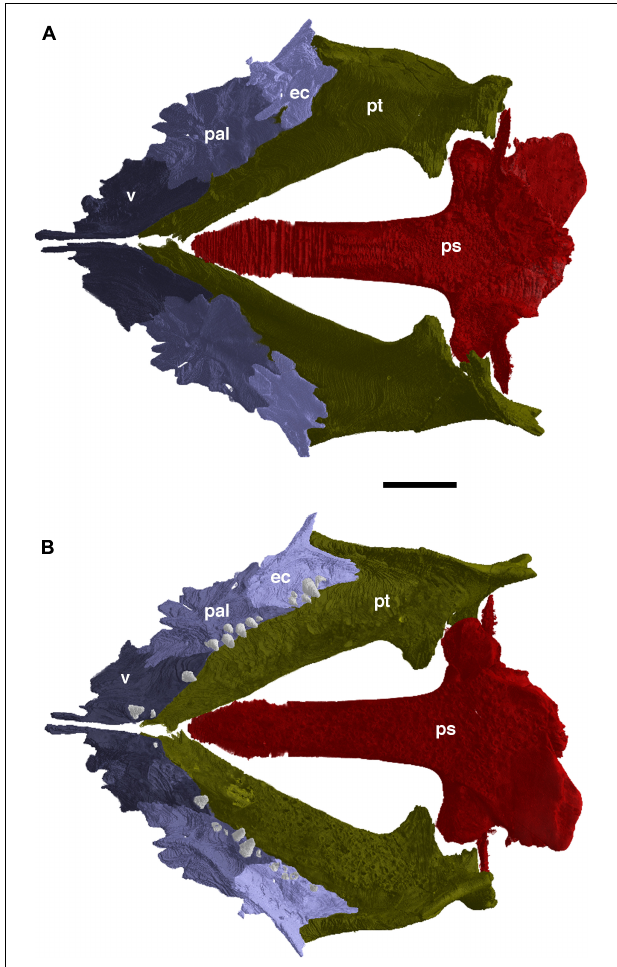
FIGURE 2 | The palate of Nannaroter mckinziei , OMNH 73107, reconstructed from CT data. (A) Dorsal view, and (B) ventral view. ec, ectopterygoid; pal, palatine; ps, parasphenoid; pt, pterygoid; v, vomer. Scale bar equals 2